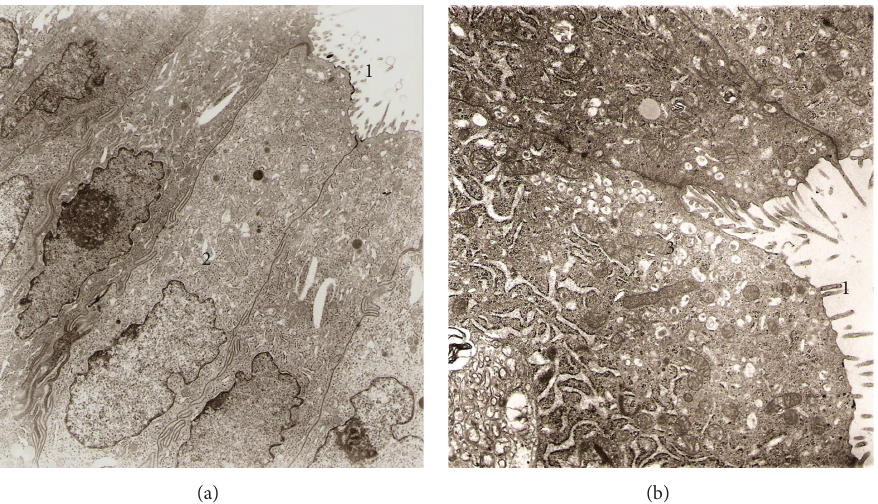
Figure 5: Electron micrographs from rat uterine horn (Control). (a) Epithelial cells showing microvilli facing to lumen (1) and normal nuclear membrane (2), 4,980x. (b) In addition numerous secretory granules and mitochondria can be observed also (3), 8,800x.